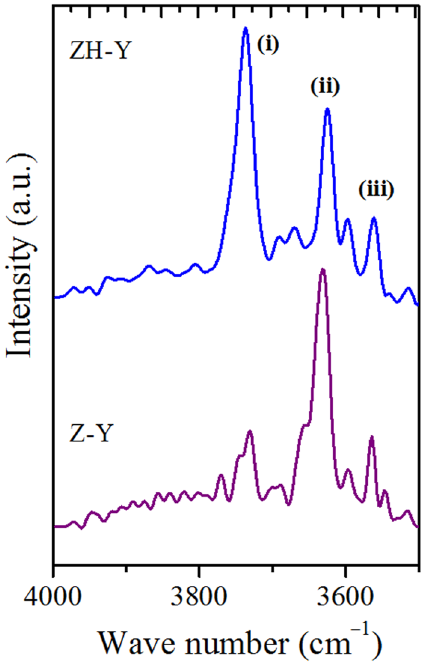
Figure 11. DRIFT spectra distinguishing various hydroxyl groups in zeolites.